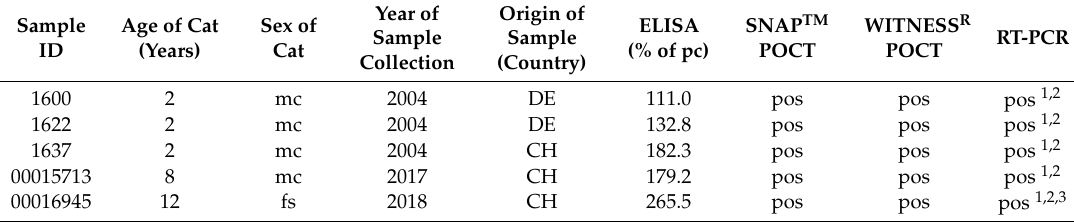
Table 5. Characteristics of five ELISA- and WB-positive control